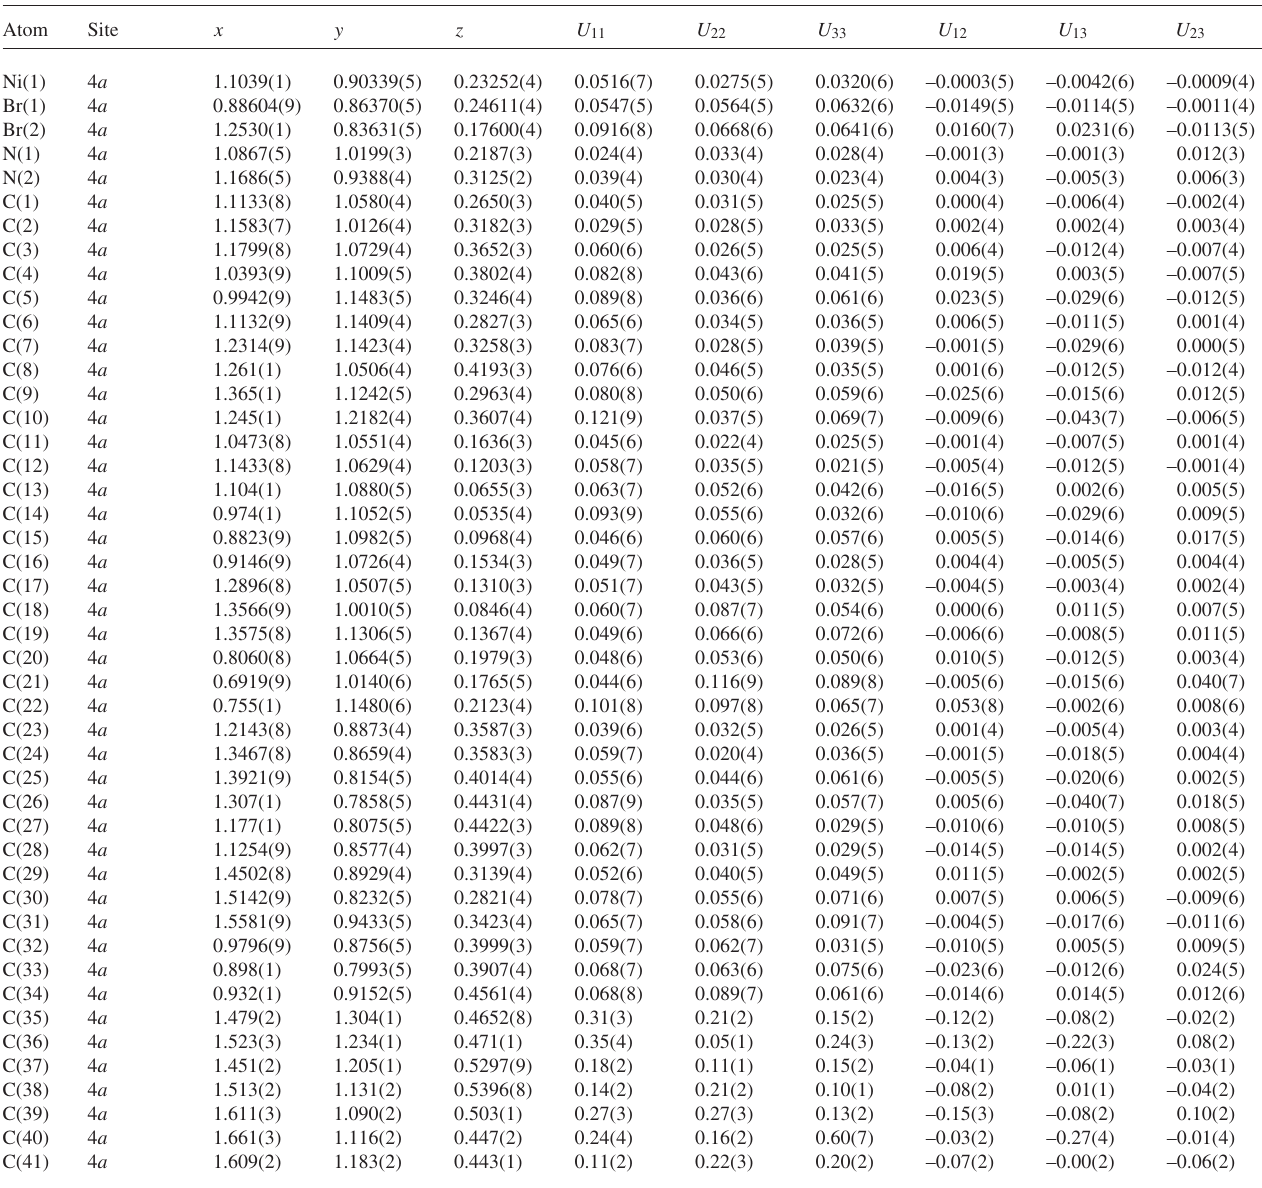
Table 3. Atomic coordinates and displacement parameters (in Å 2 )